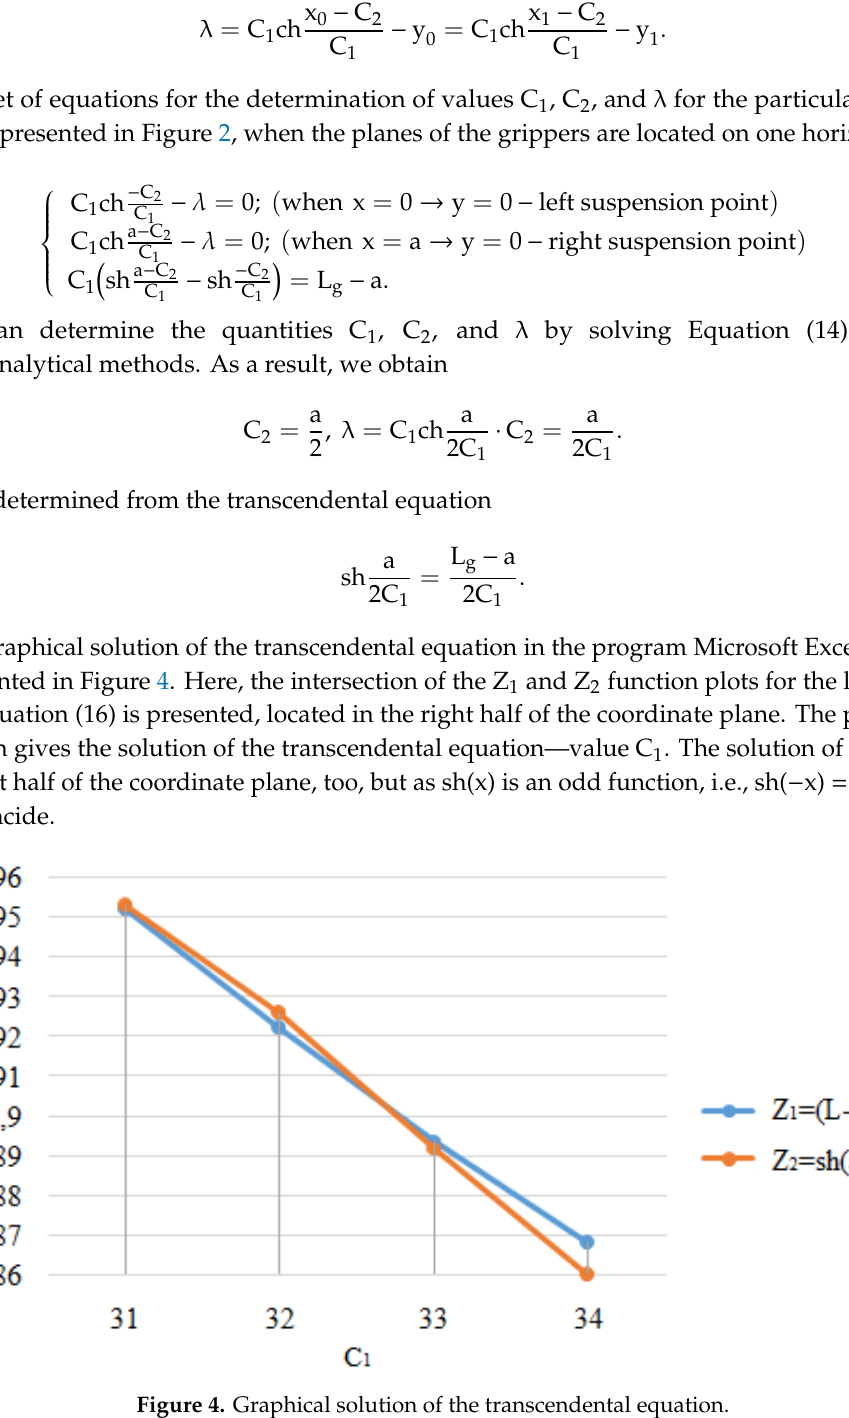
Figure 4. Graphical solution of the transcendental equation.